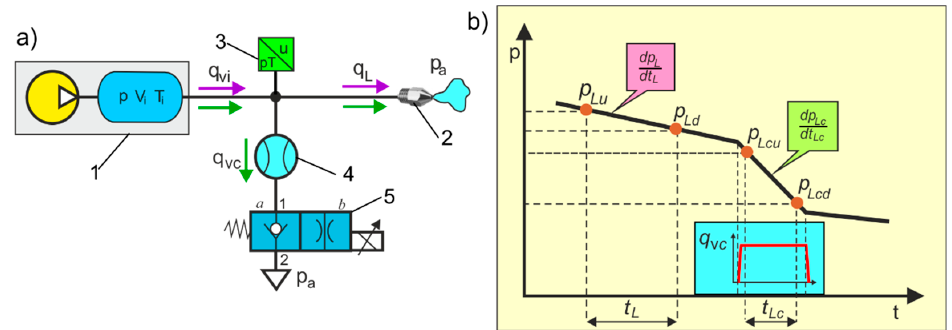
Figure 6. The principle of indirect measurement of leakage flow rate in air piping, ( a ) basic diagram of the measuring system: 1—compressed air station, 2—air nozzle, 3—dual p/T transducer, 4—flow meter, 5—2/2-way throttle control valve, normally closed (NC), electrically operated (position a valve is closed, position b valve is open), ( b ) measurement points of pressure drop ratios and controlled flow rate in two-time intervals.